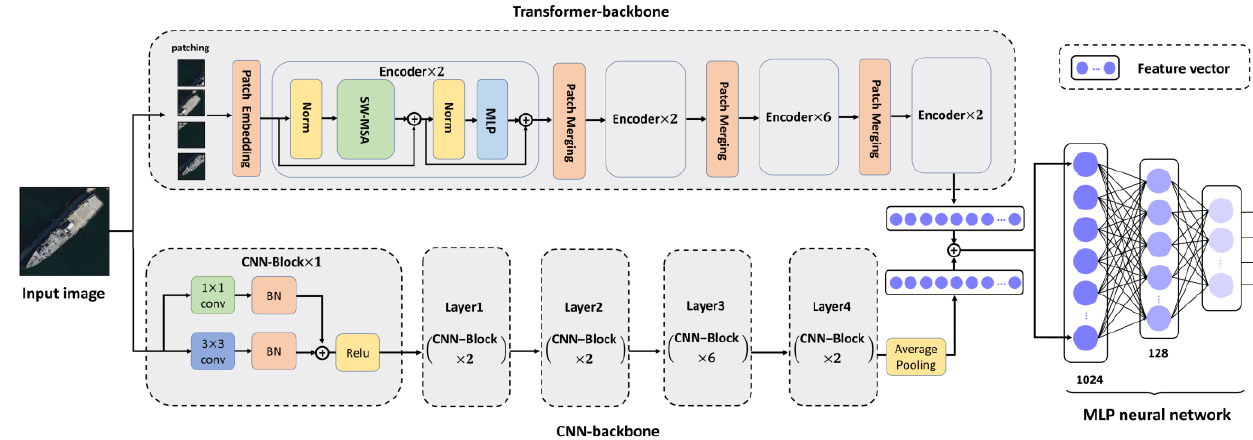
Figure 1. Network architecture of the proposed model.